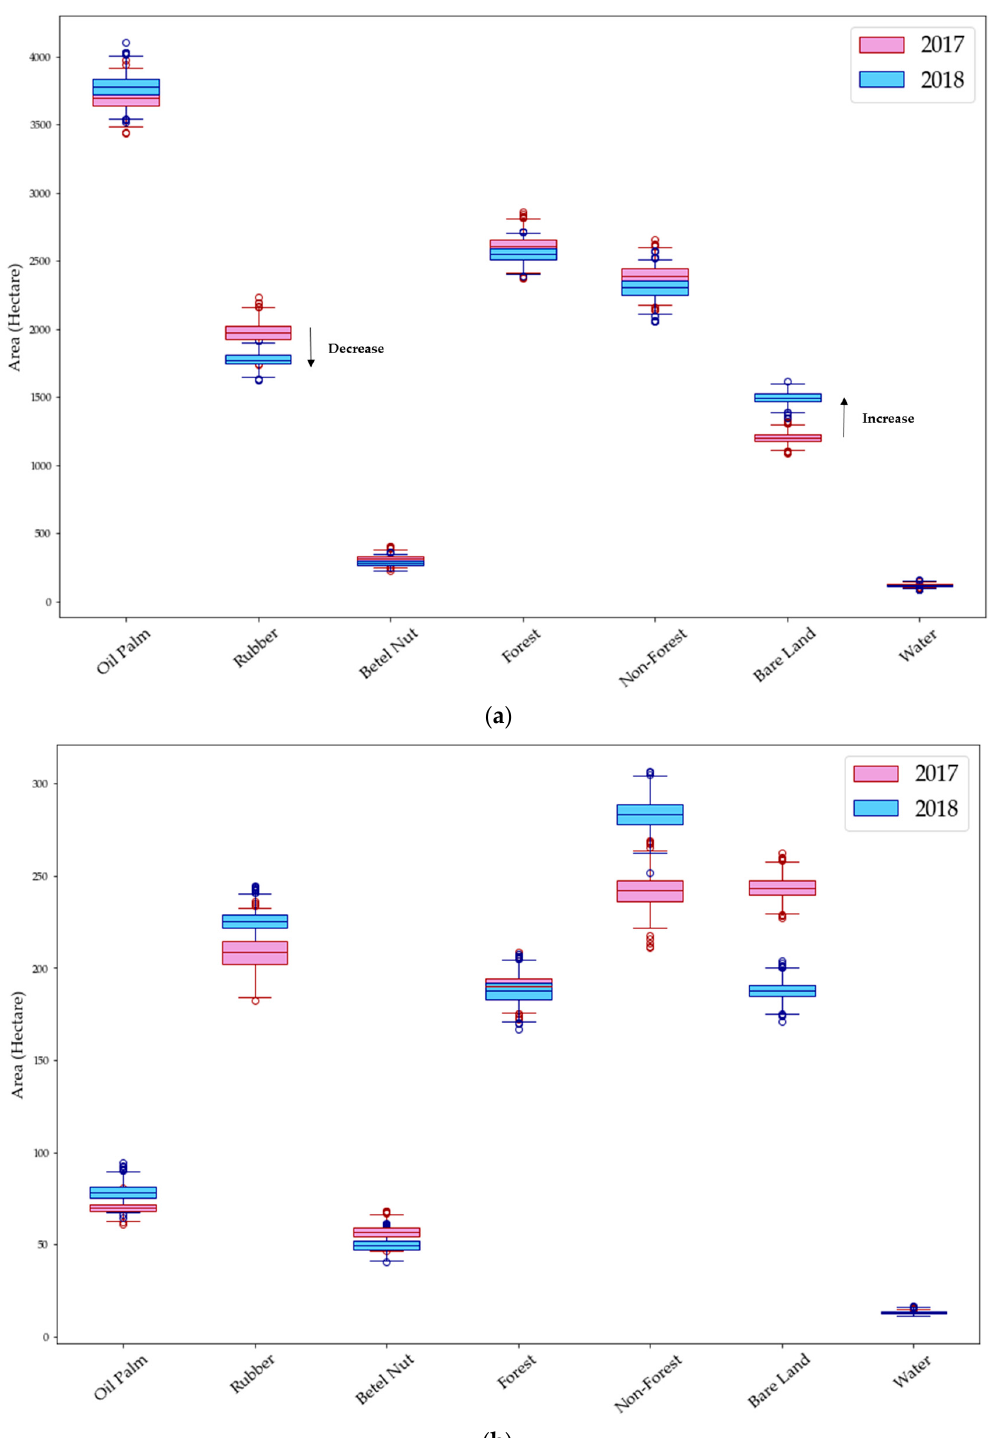
Figure 7. Classification results: area changes by class in ( a ) Area A; ( b ) Area B.